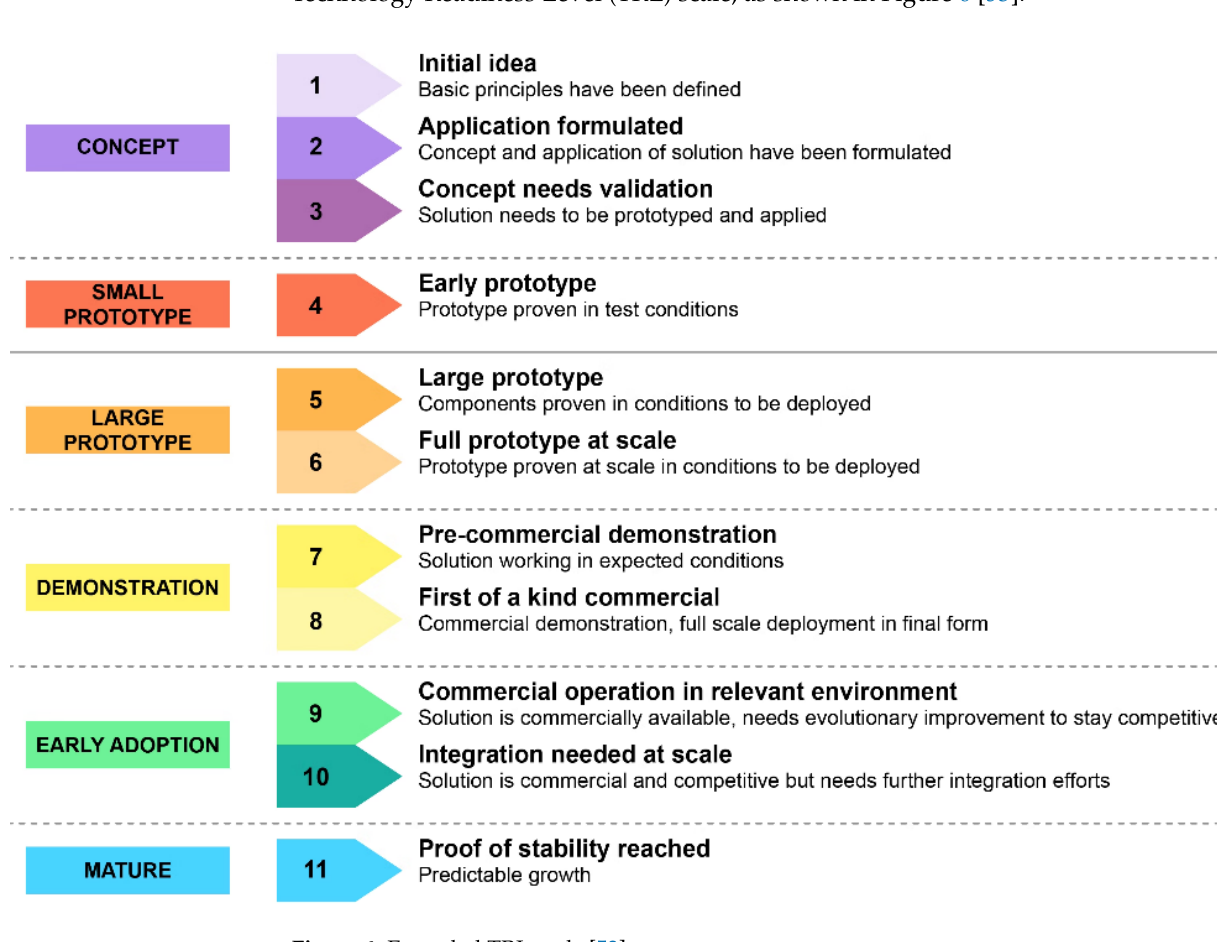
Figure 6. Extended TRL scale [53].